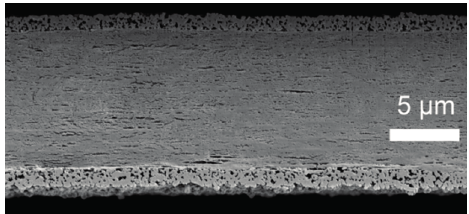
Figure 6. SEM picture of the cross section of separator COATED prepared by ion beam